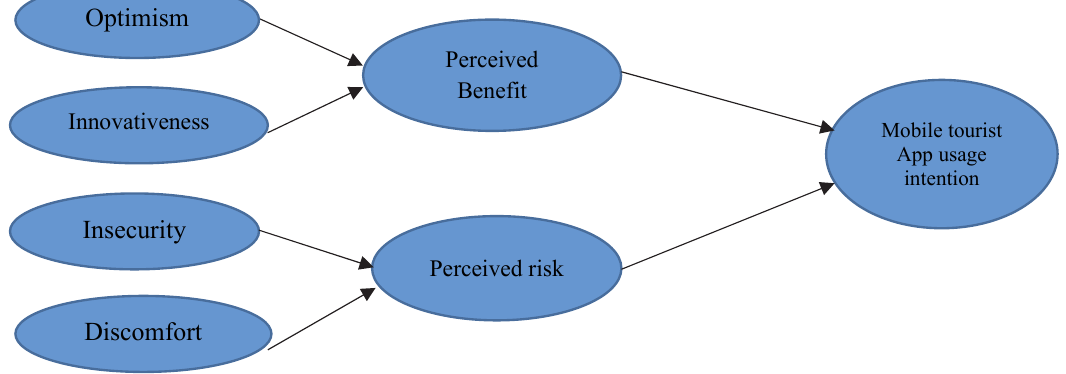
Fig. 1. Conceptual model based on the TRI model to measure intention to use mobile tourist applications (inDubai App) Source: Adapted from Pradhan, Oh and Lee